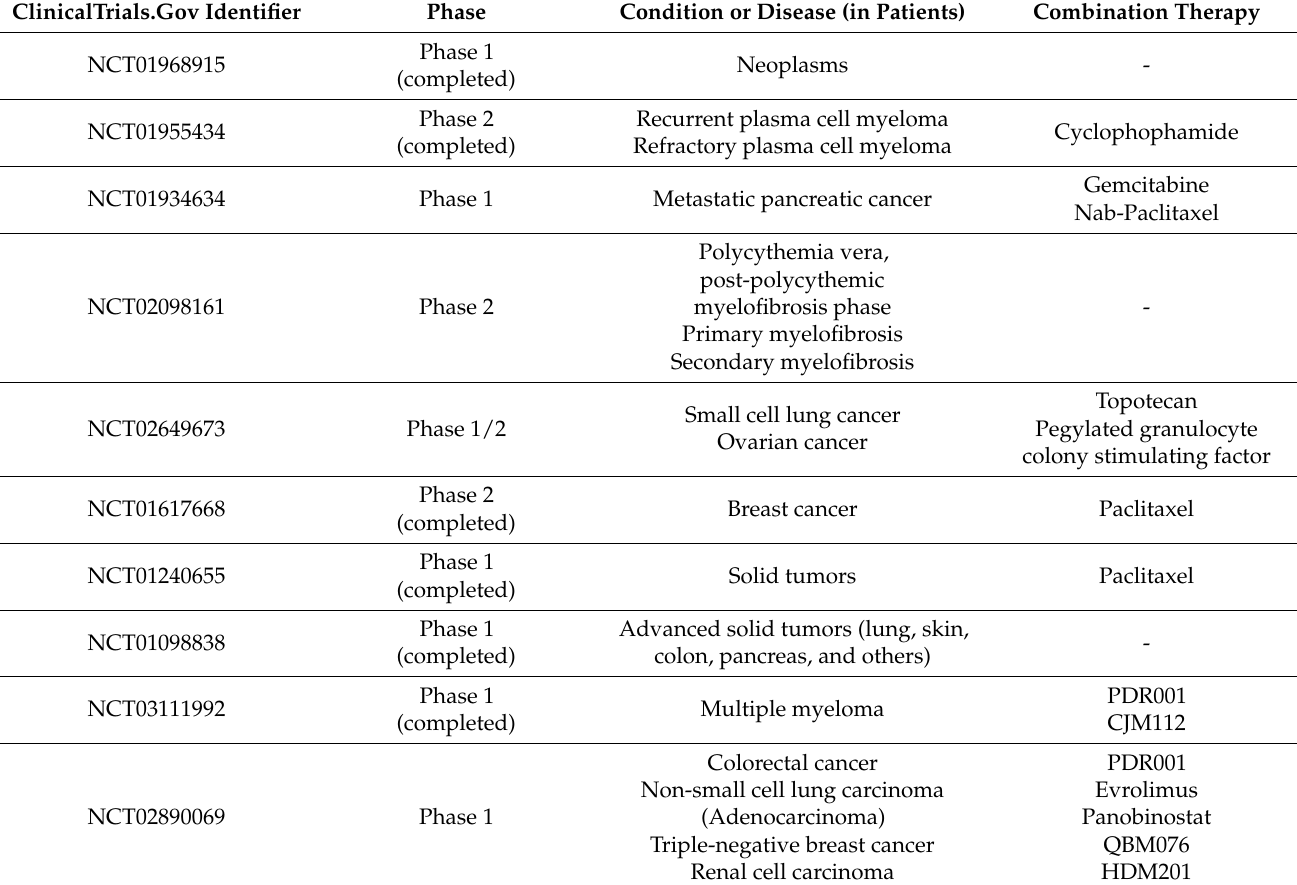
Table 1. Clinical status of LCL161 for cancer